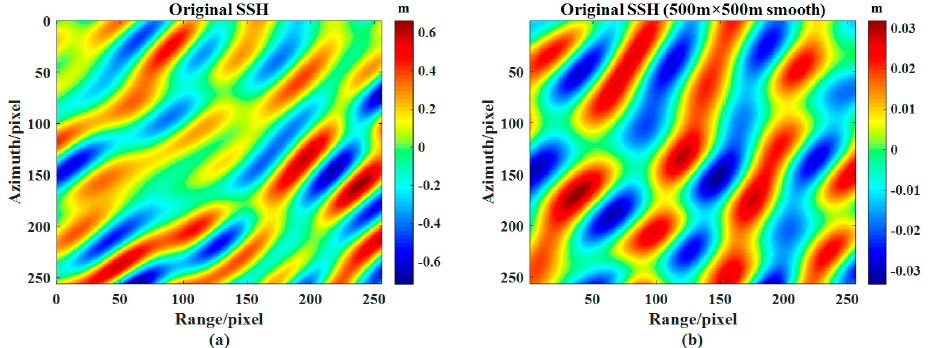
Figure 9. Unsmoothed ( a ) and smoothed ( b ) original SSH (in m). The SWH is selected as 2 m. The smoothing window size is 500 m × 500 m, and the pixel size is 5 m × 5 m.